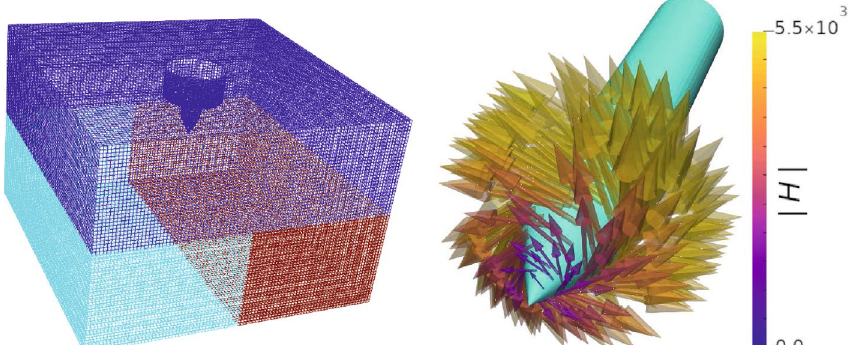
Figure 5. Computational domain for the electric arc welding case ( a ), showing an exploded view of the electrode and the boundary condition in H applied at the electrode surface ( b